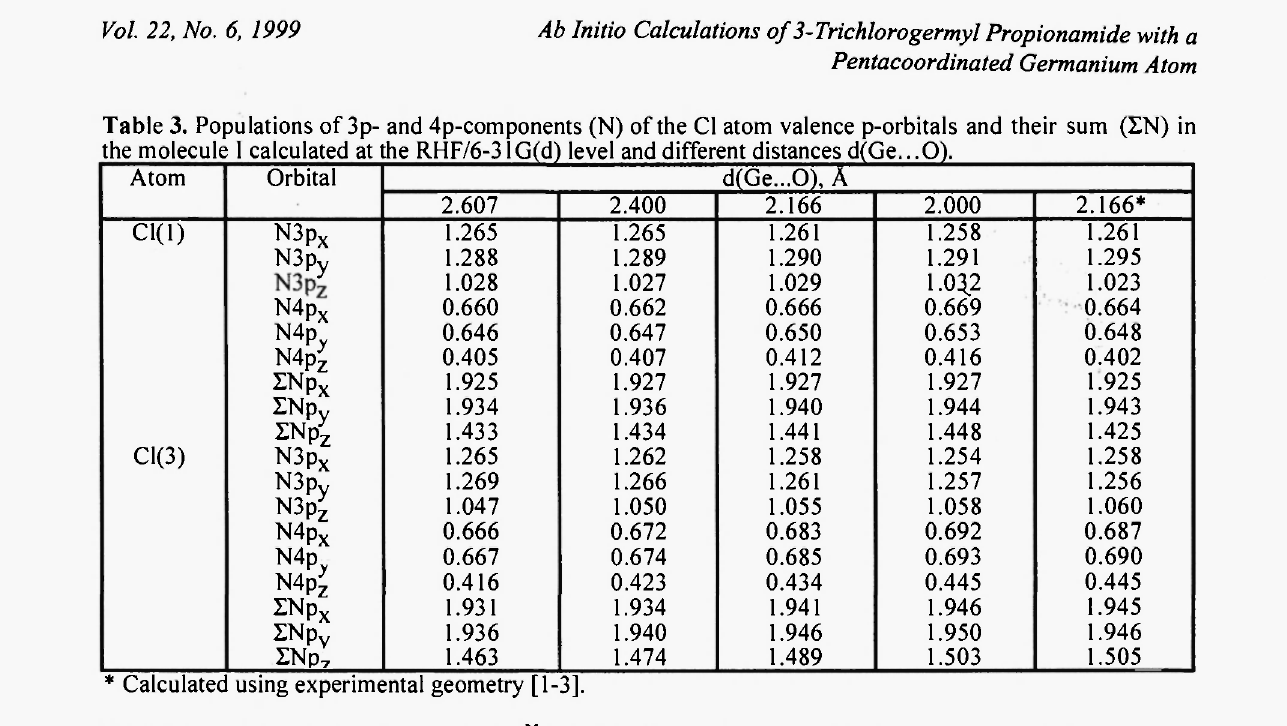
Table 3. Populations of 3p- and 4p-components (N) of the CI atom valence p-orbitals and their sum (ΣΝ) in the molecule I calculated at the RHF/6-3 lG(d) level and different distances d(Ge.. .O).